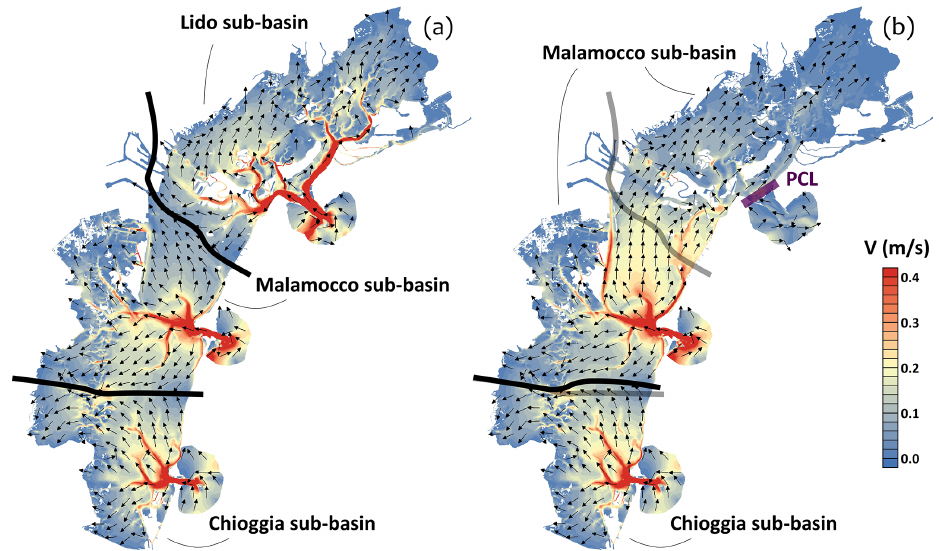
Figure 6. Sinusoidal tide, no wind (scenario I). Tidal range 0.8m and tidal period 6h. The two panels represent the two-dimensional velocity field and watershed locations (solid black lines) during at the 5th hour of the seaward flood tide. (a) Unregulated lagoon; (b) PCL.